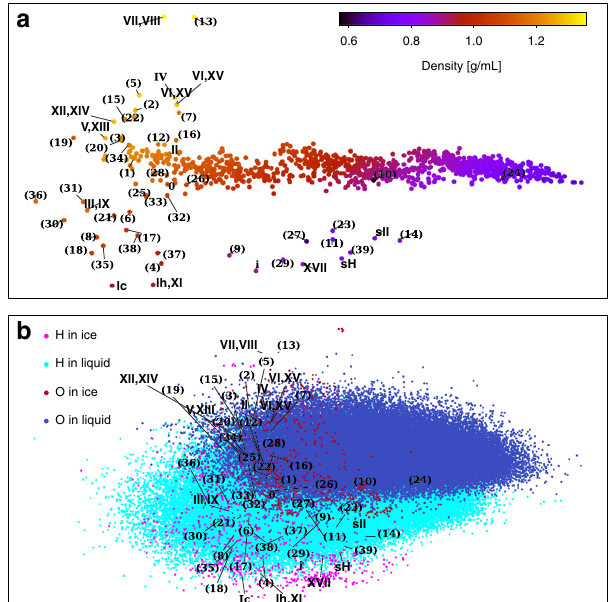
Fig. 1 PCA maps for the 54 ice phases and the 1000 liquid water con fi gurations. The geometries of the ice phases have been optimized by HSE-3c. If known, each ice structure is labeled by the name of the proton ordered and disordered phase, and otherwise by a number. a Each dot indicates a structure, which is described by global descriptors. b Each small dot indicates the projection of a oxygen or hydrogen-centered local